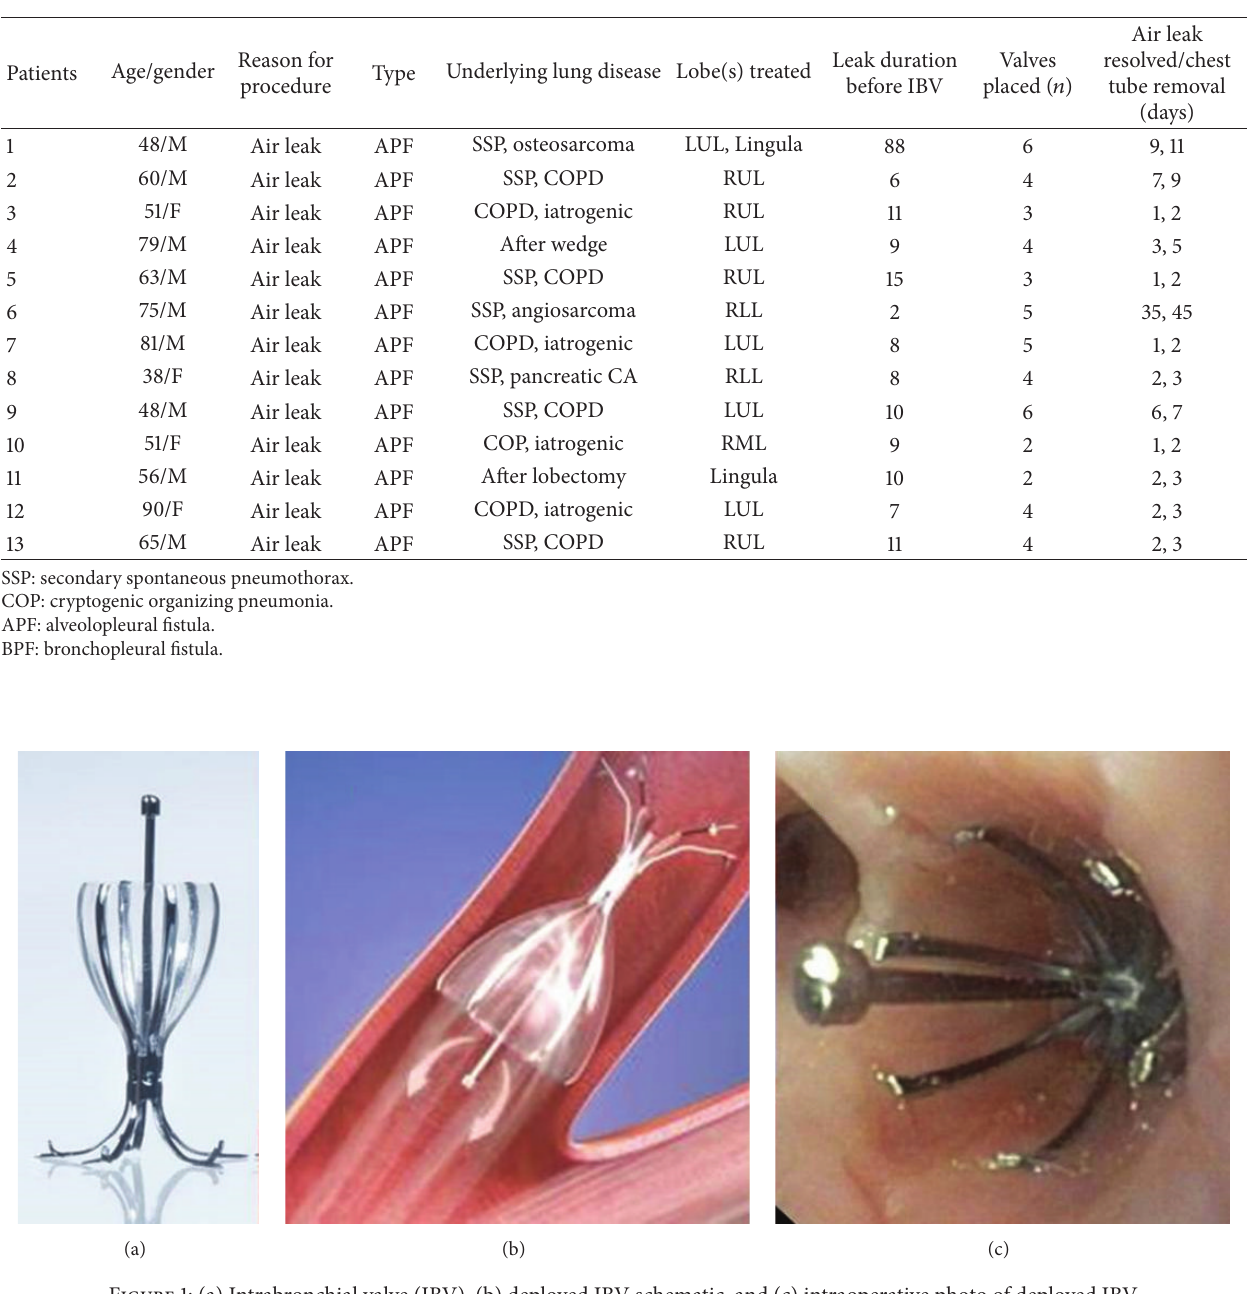
Table 1: Patient characteristics and